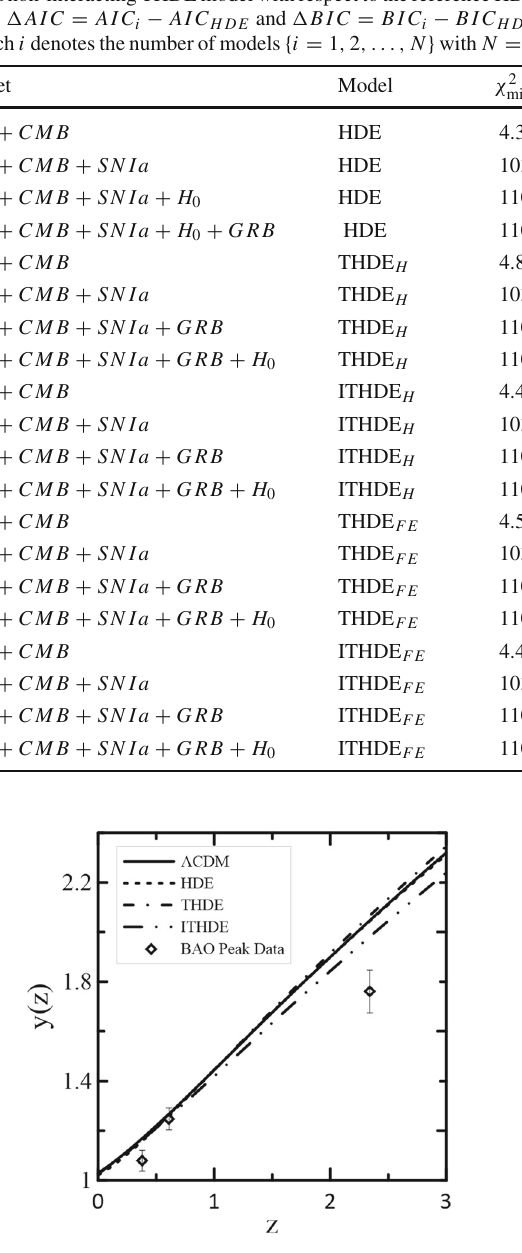
Fig. 3 The evolution of AP test versus redshift for the THDE model with consideration of the Hubble horizon as IR cutoff. The data used for plotting the trajectories of (cid:2) CDM, HDE, THDE and ITHDE is the CMB + BAO category